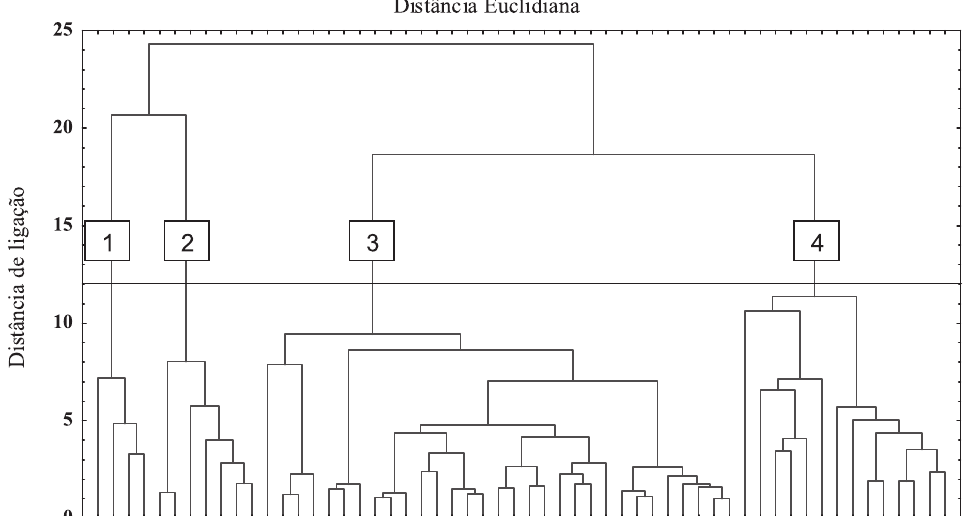
figura 1. dendrograma de classificação das amostras de solo em quatro grupos, em função das variáveis silte+argila, co, co, cr, cu, fe, Mn, Mo, ni, ti, v e